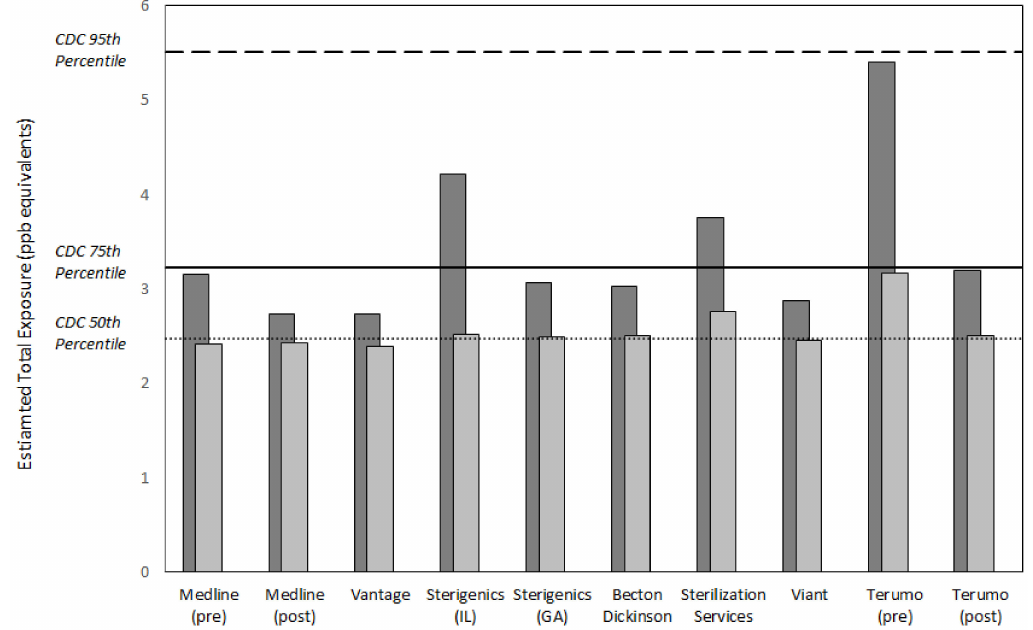
Figure 4. Estimated total equivalent exposure to EO in the vicinity of eight sterilization and other EO-emitting industrial facilities relative to that of the 50th, 75th, and 95th percentiles of the non-smoking U.S. population (2.5, 3.2, and 5.5 ppb, respectively). Light gray = [50th percentile endogenous equivalent for the non-smoking U.S. population, or 2.3 ppb] + [50th percentile EO concentration for the facility area from Table 3]. Dark gray = same as light gray, except using 90th percentile EO concentration for the facility area from Table